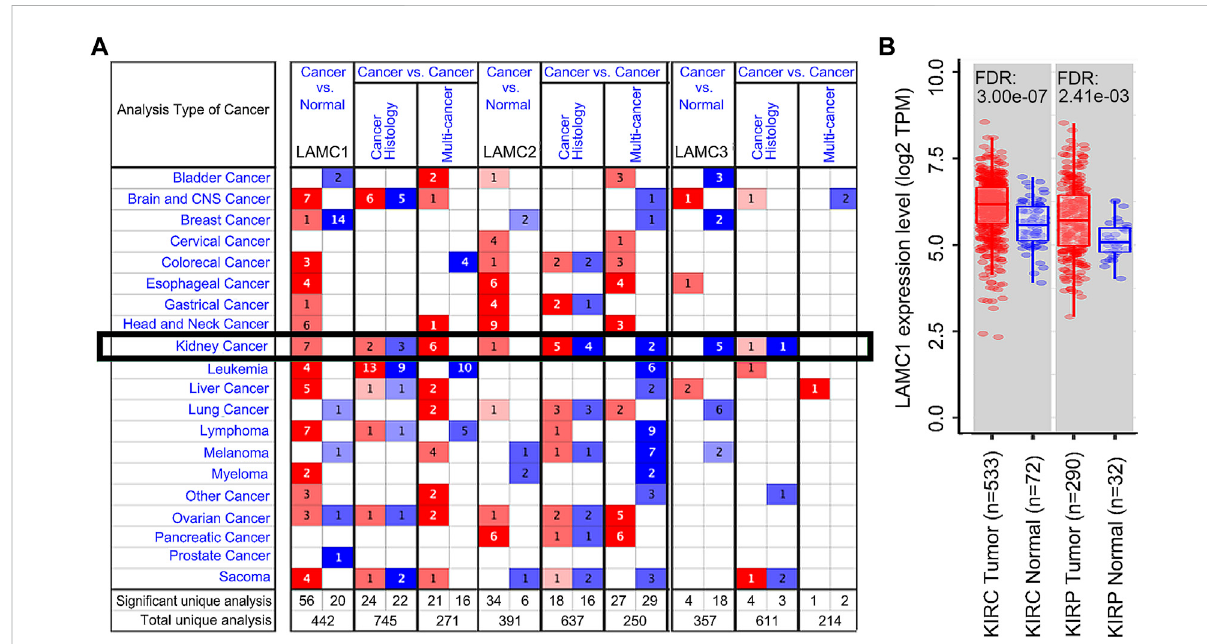
FIGURE 1 Theexpressionlevelsof LAMC1 acrosshumancancersatmRNAlevel. (A) TheexpressionlevelsofLamininC( LAMC )familymembersindifferent types of cancers based on Oncomine database. The number in each cell represents signi fi cance datasets of genes up-regulated or down-regulated in a particular cancer. Red box represents high expression in tumors, blue box represents low expression in tumors and white box represents no differenceintumorsandnormaltissues. (B) Differentialexpressionlevelsof LAMC1 inKIRPandKIRC betweentumorgroupsandnormalgroups based on TIMER